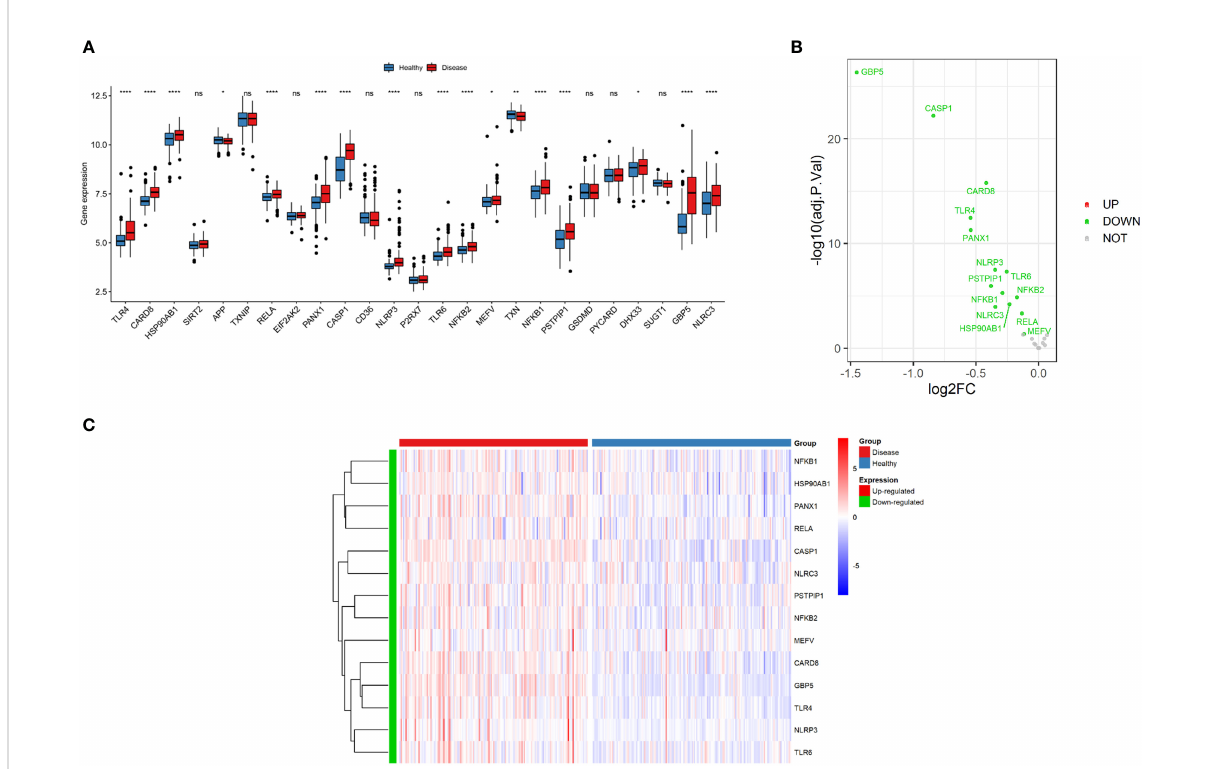
FIGURE 2 Expressions of NLRP3 in fl ammasome-related genes. (A) Box plot demonstrating the overview of gene expressions in the GSE100833 dataset. Blue: healthy (non-in fl amed) tissues; Red: diseased (in fl amed) tissues. (B) Volcano plot illustrating the differentially expressed genes (DEGs) in the GSE100833 dataset. Green: downregulation. Red: upregulation. Grey: not signi fi cantly altered. (C) Heatmap for the DEGs in the GSE100833 dataset. Blue: tissues from healthy control; Red: tissues from patients with Crohn ’ s disease. ns: P ≥ 0.05; *: P < 0.05; ** P ≤ 0.01; **** P ≤